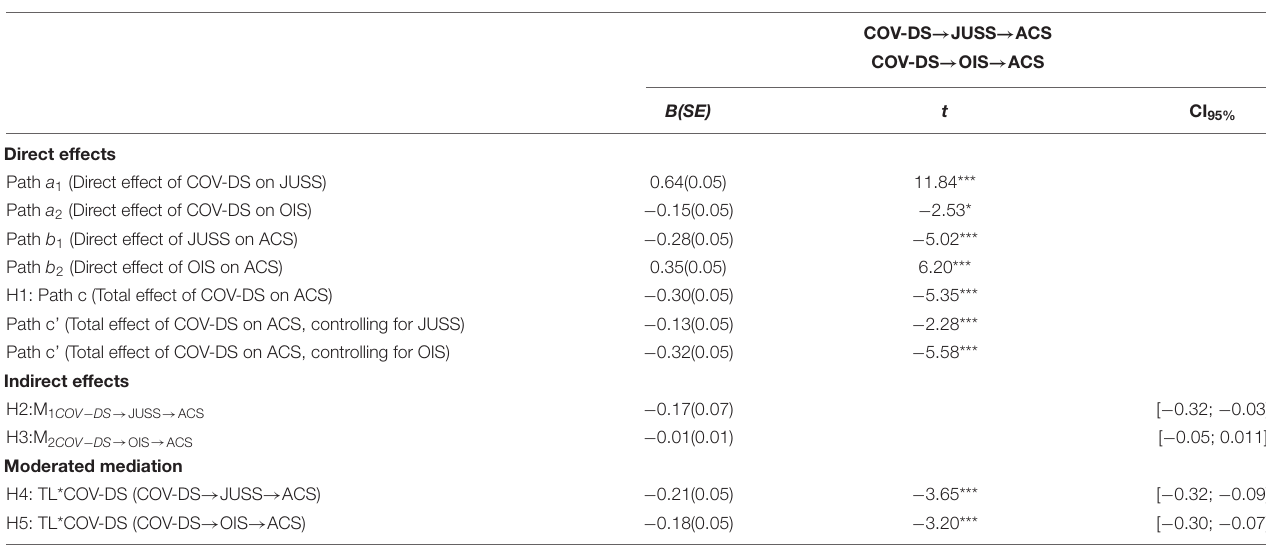
TABLE 3 | Mediation and moderation